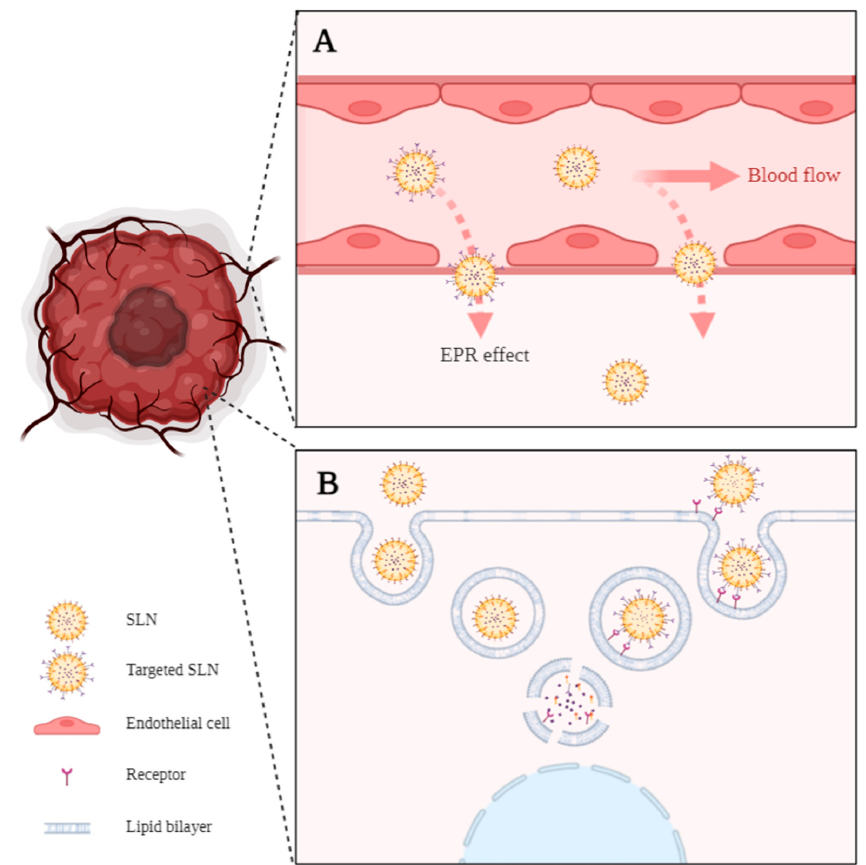
Figure 2. ( A ) Enhanced permeability and retention effect (EPR effect). Passive targeting is explained